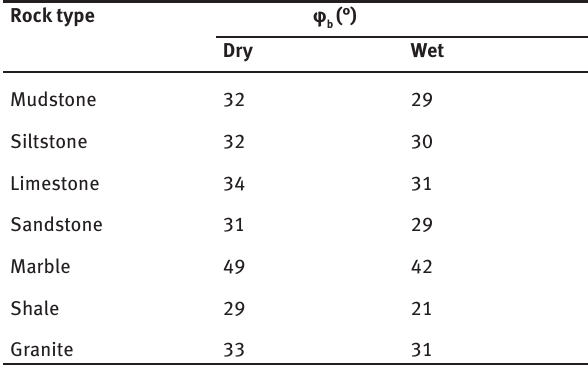
Table 3: Shear strength of rock fractures under dry and wet conditions (data from Barton 1973; Alejano et al.